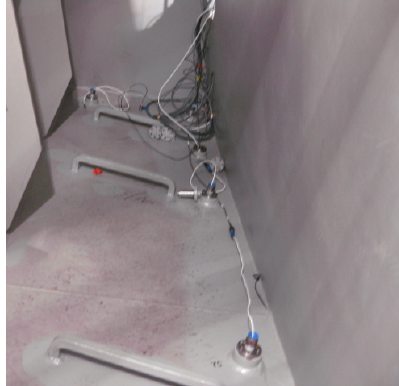
Figure 19. Pressure sensors at C 0, S 1, and S 2 installed on the line of the propeller